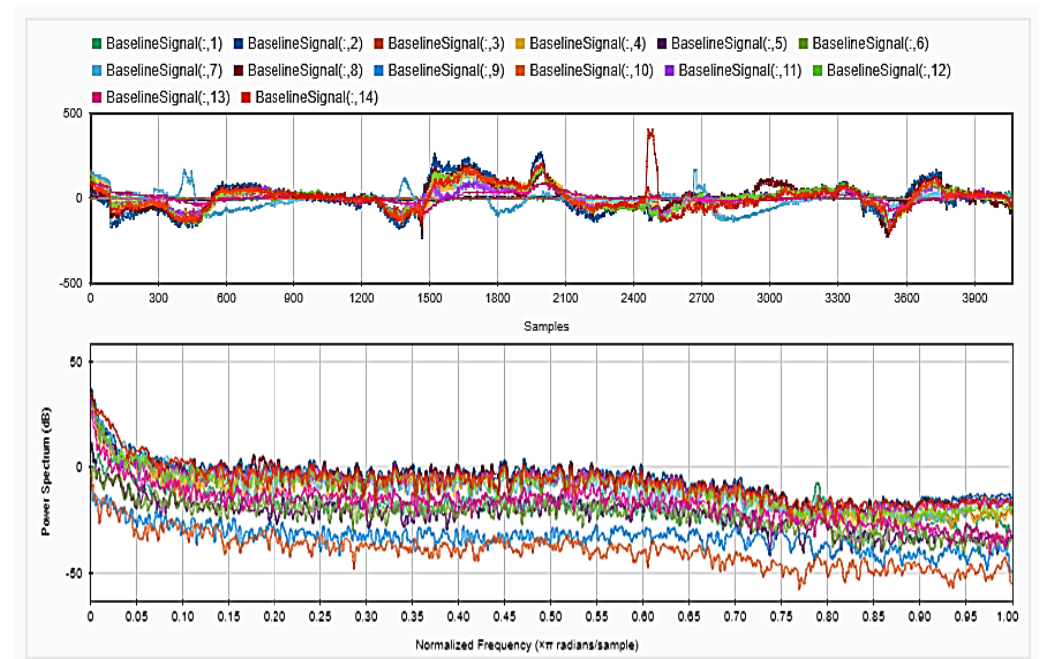
Figure 8. Baseline signal for the 14 channels in time ( upper ) and frequency ( lower ) domains.